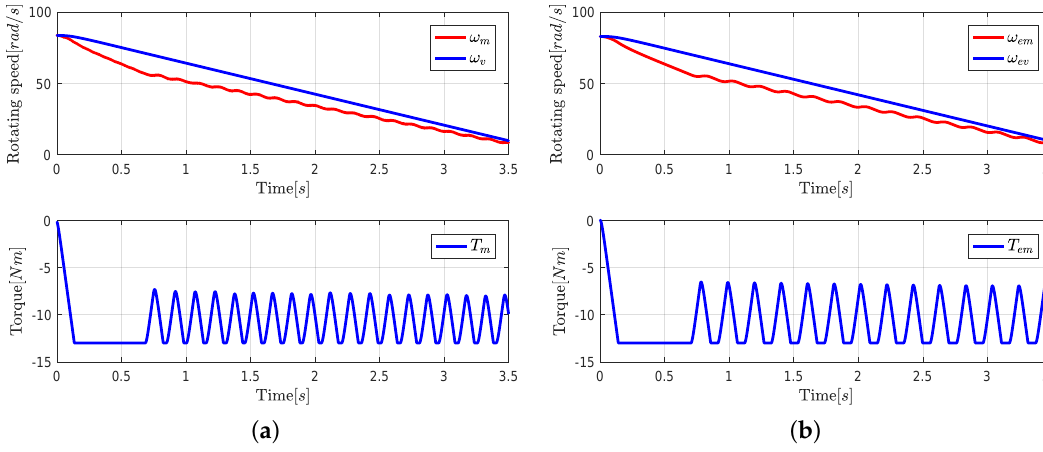
Figure 10. The responses of the motor torque T m with the nonlinear controller (25): T B = 0.01 and γ B = 100. ( a ) The experimental results. ( b ) The simulation